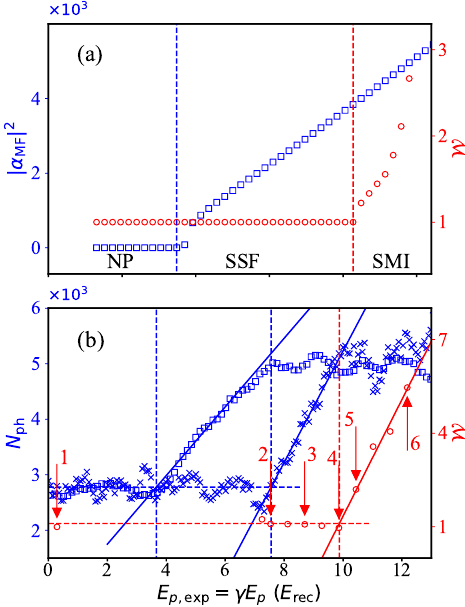
| 2 , intracavity photon number N Figure 6: Cavity field magnitude | α , and the rel- MF ph = γ E ative width of the central Bragg peak W as functions of pump strength E p ,exp p = − 2 π × 30 kHz. The relative width of the central Bragg peak at fixed detuning ∆ eff for the BEC is set to be W = 1. As the pump strength increases, the system tran- sitions through all three phases, i.e., NP, SSF, and SMI. Panel (a) shows simulated | 2 (blue squares) obtained from the mean-field M = 1 steady-state results for | α MF simulations, and W (red circles) obtained from the beyond-mean-field M = 4 simu- = 40 ms ramping lations. Panel (b) shows experimentally measured N for the T r ph protocol (blue squares), as well as N (blue crosses) and W (red circles) for the ph = 20 ms ramping protocol. A background radiation of N ≈ 2.7 × 10 3 originates T r ph from the diffuse light forming the external lattice potential. This background count offset can be safely subtracted for the determination of the NP–SSF boundary. The numbers indicate the representative points whose simulated and measured density distributions are shown in Fig.